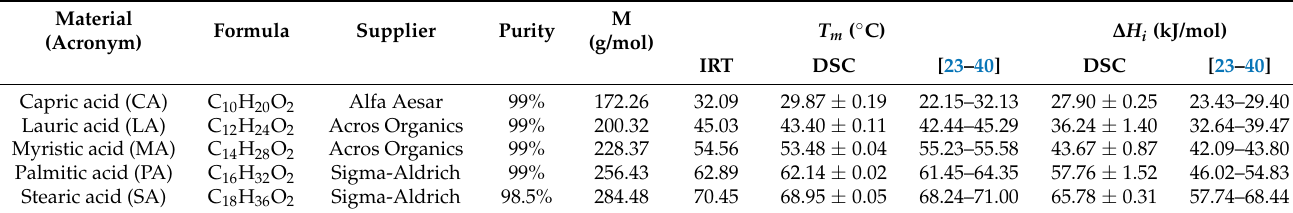
Table 1. Pure materials provided by Alfa Aesar (Haverhill, MA, USA), Acros Organics (Fair Lawn, NJ, USA) and Sigma- Aldrich (St. Louis, MO, USA) and melting temperatures and enthalpies from our IRT and DSC measurements and as stated in the literature